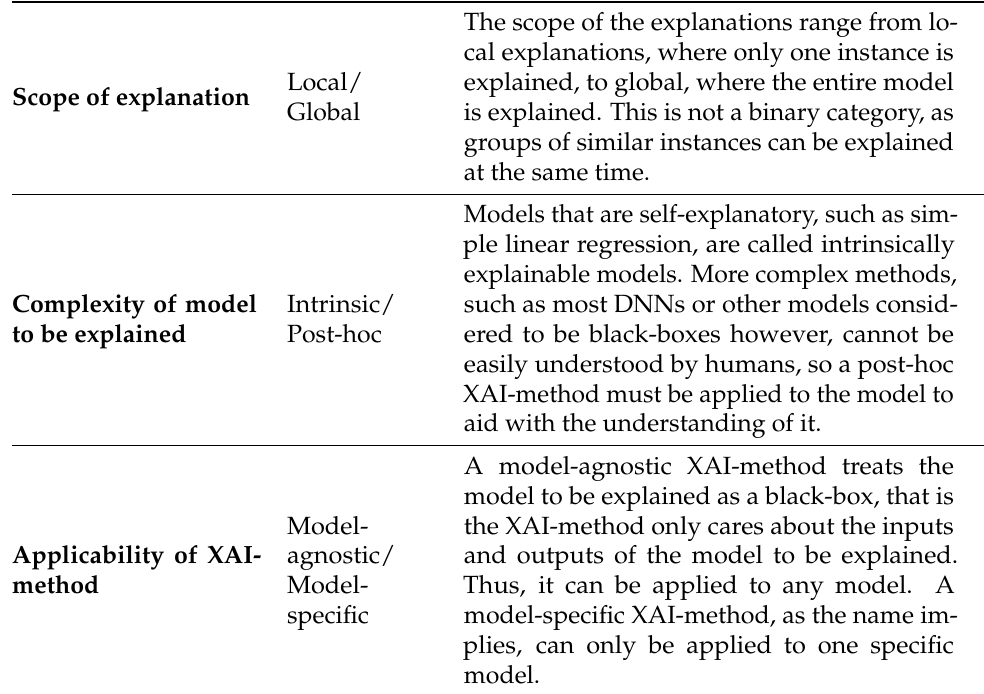
Table 1. Main characteristics of